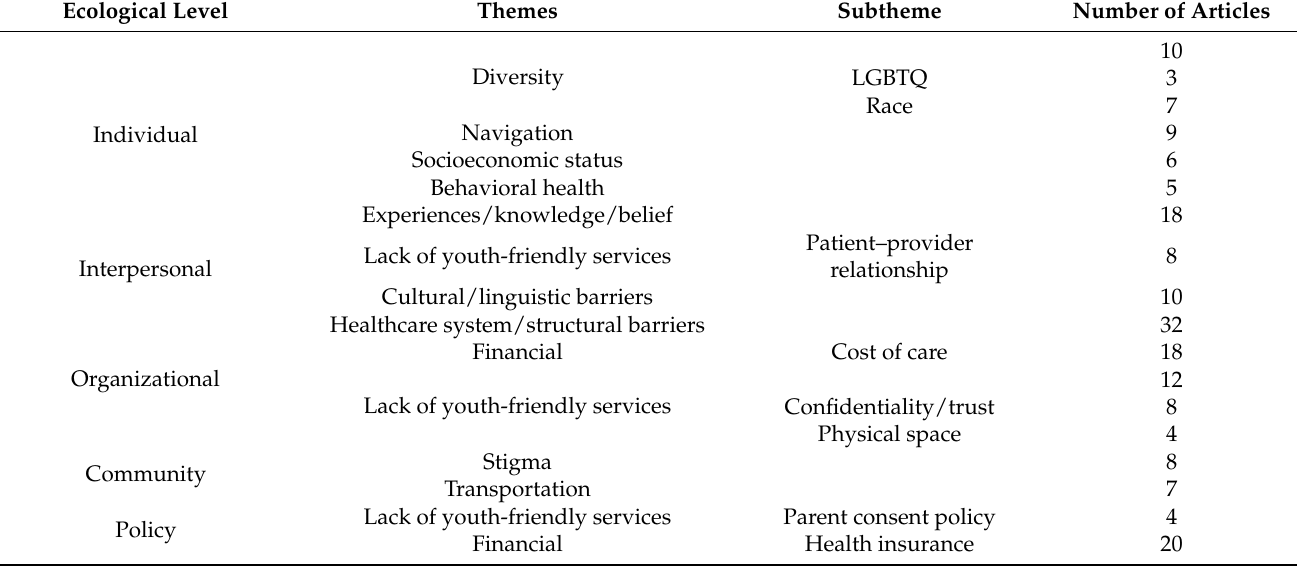
Table 2. Barriers to Access to Care for Adolescents according to the Social-Ecological Model. Ecological